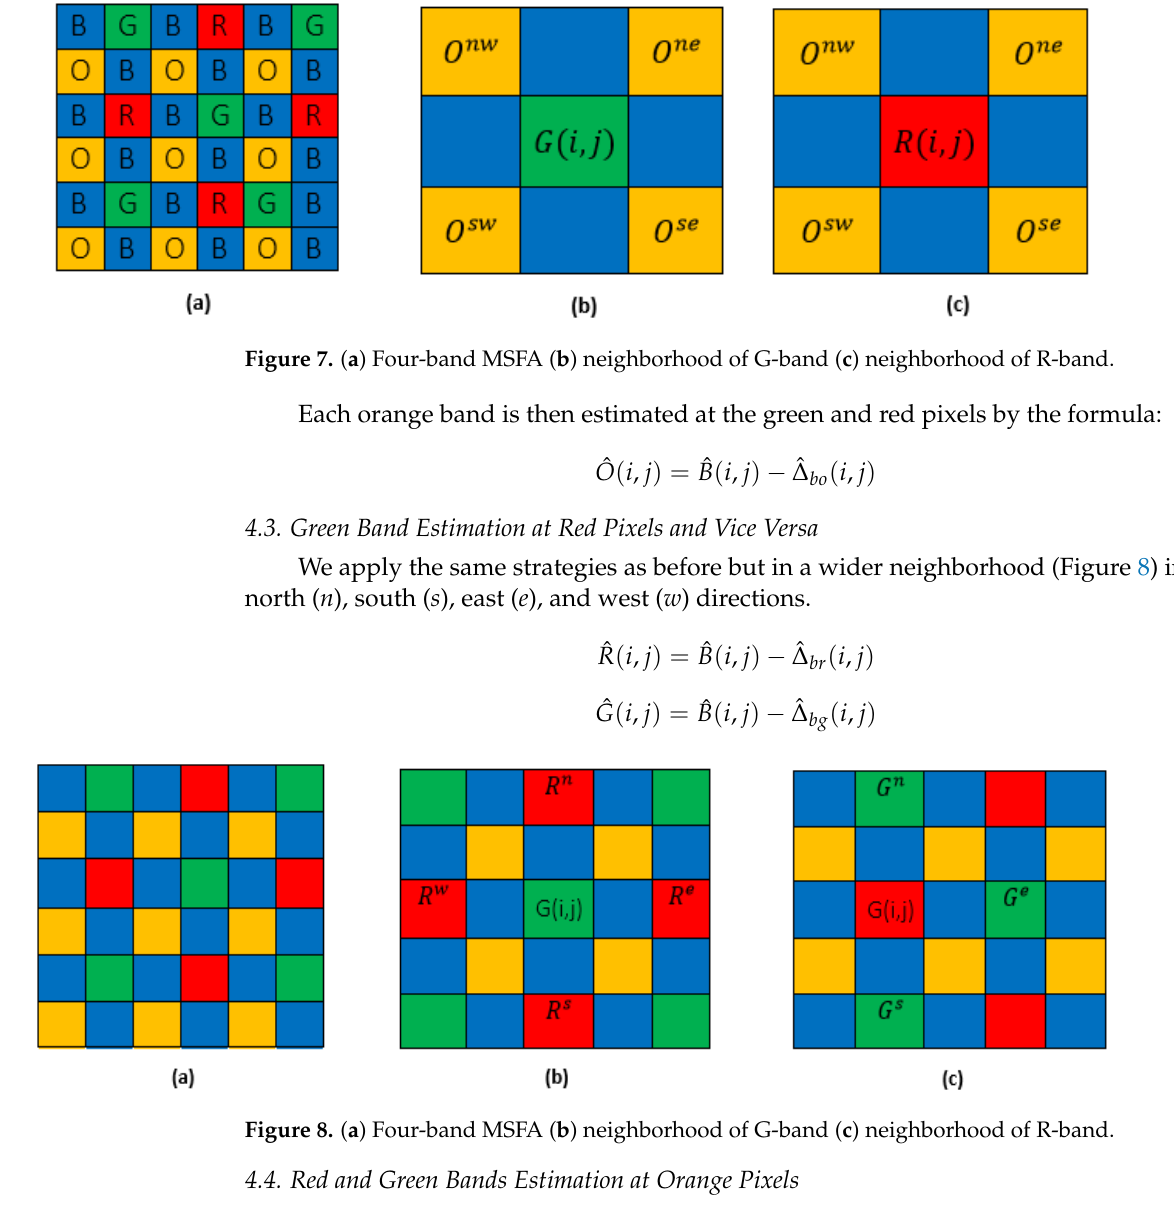
Figure 8. ( a ) Four ‐ band MSFA ( b ) neighborhood of G ‐ band ( c ) neighborhood of R ‐ band.